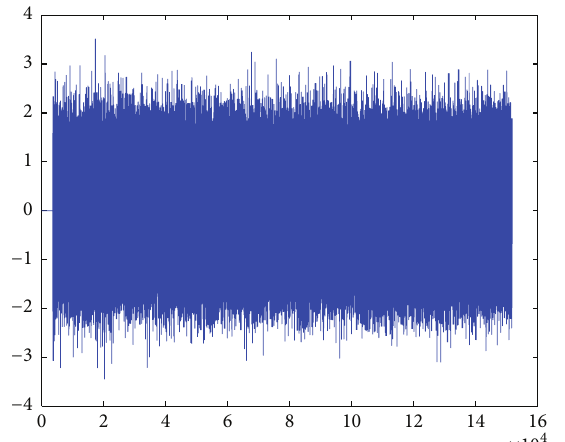
Figure 8: Temporal waveform of the conventional DCT precoded QPSK OFDM signal.